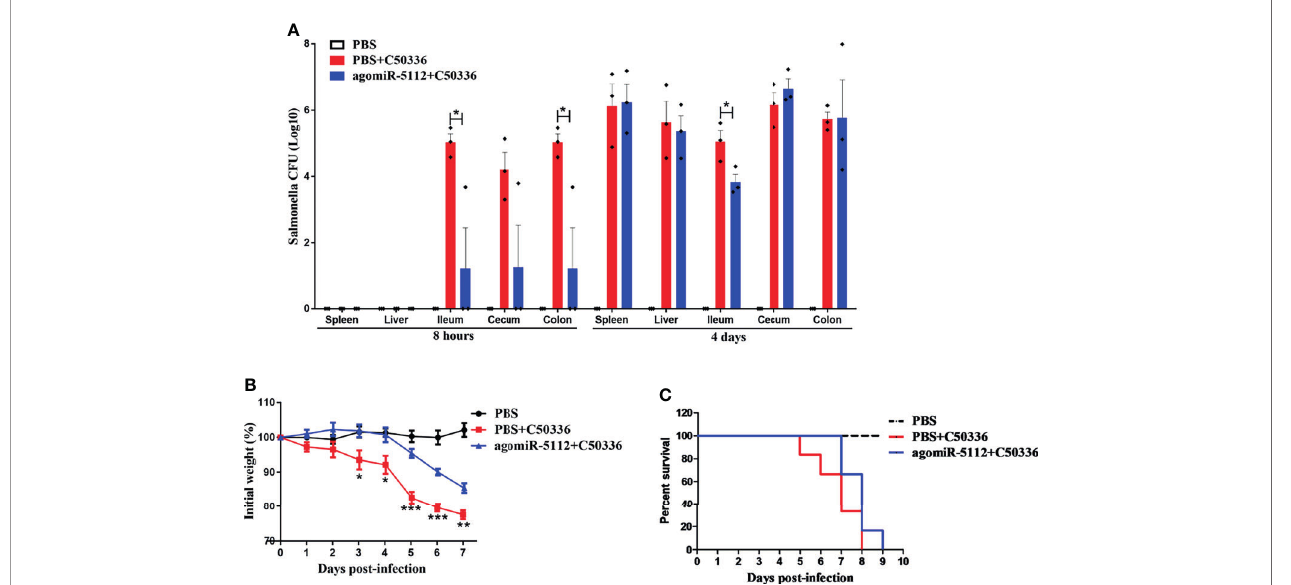
FIGURE 6 | Exogenous miR-5112 agomiR delays mouse death induced by S . enteritidis infection. The agomiR-5112 injection and Salmonella infection procedures were performed as described in Figure 6 . (A) Salmonella loads in mice organs (spleen, liver, ileum, cecum and colon, n=3/group) were determined at 8 h and 4 d after Salmonella infection. The number of bacteria was expressed as log 10 CFU/g. Data are expressed as the mean ± SEM. * P < 0.05. (B) Changes in body weight of mice (n=6/group) were monitored daily for 7 days after Salmonella infection. Data are expressed as the mean ± SEM. ** P < 0.01; *** P < 0.001 versus PBS+C50336 group (C) The survival of mice (n=6/group) was monitored daily after Salmonella